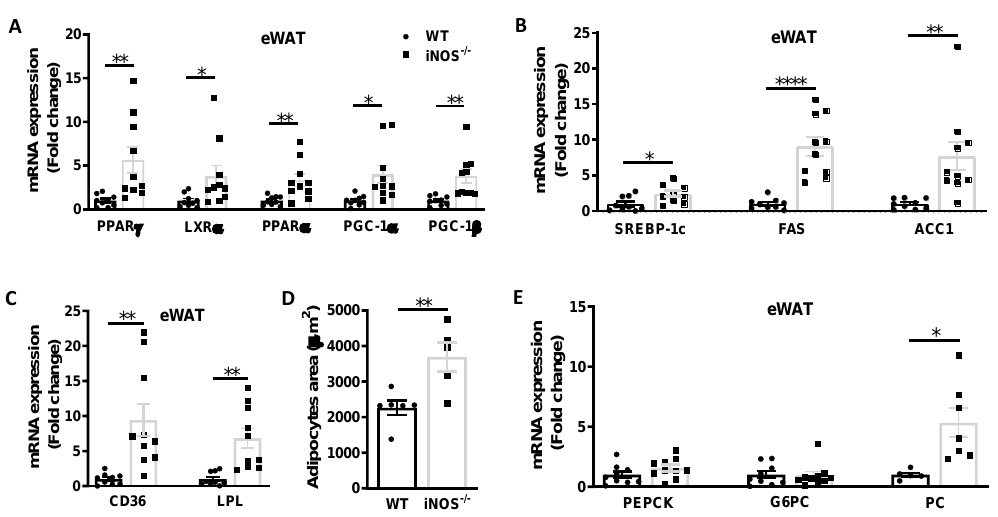
Figure 3. Metabolic homeostasis in adipose tissue of chow fed WT and iNOS −/− mice. ( A ) qPCR expressions of transcriptional regulators involved in lipid synthesis (WT: n = 9, iNOS −/− : n = 10): PPARy and LXRα and genes involved in fatty acids oxidation: PPARα, PGC - 1α , and PGC- 1β. ( B ) qPCR expression of genes involved in lipid synthesis (WT: n = 9, iNOS −/− : n = 10): SREBP-1c, FAS, and ACC1. ( C ) qPCR expression of genes involved in lipid uptake (WT: n = 9, iNOS −/− : n = 10): CD36 and LPL. ( D ) Mean adipocyte area (WT: n = 6, iNOS −/− : n = 5). ( E ) qPCR expression of genes involved in gluconeogenesis (WT: n = 9, iNOS −/− : n = 10): PEPCK, G6PC, and PC (WT: n = 5, iNOS −/− : n = 7) in chow fed WT and iNOS −/− mice. Data are represented as mean ± SEM. Black circles: WT, black squares: iNOS −/− mice. * p < 0.05, ** p < 0.01, **** p < 0.0001 vs. WT.